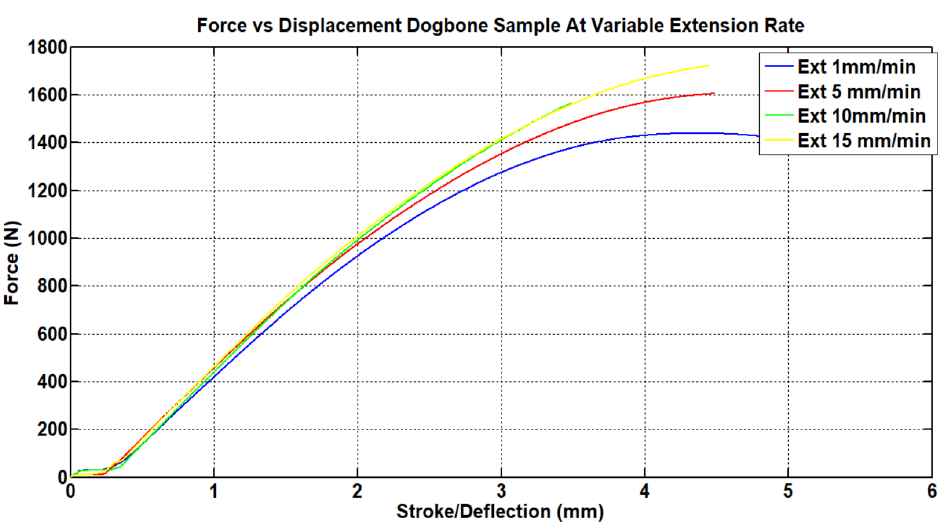
Figure 7. Load vs. displacement graph for acrylic dog-bone samples. 5. Results and Discussion The force vs. displacement results obtained for the structure under loading in the x- and y-directions can be seen in Figure 8. As we increase the values of a/L , the structure becomes more compliant at the expense of failure force.